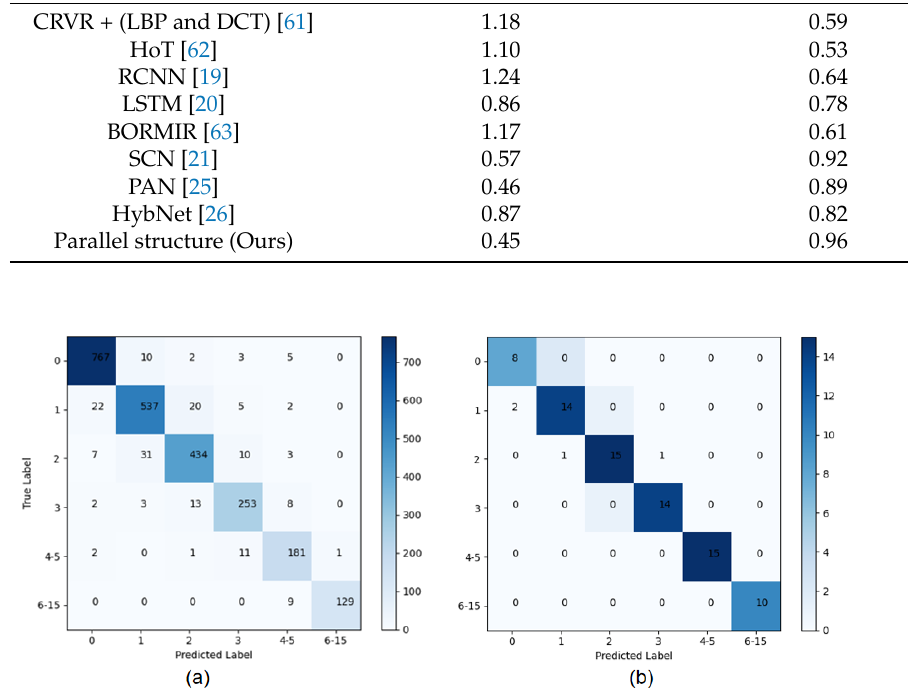
Figure 9. Confusion matrix for the prediction results of pain frames based on Parallel CNNs . ( a ) shows the confusion matrix for the predicted results of the whole test dataset, and ( b ) shows the confusion matrix for the predicted results of an 80-frame video.